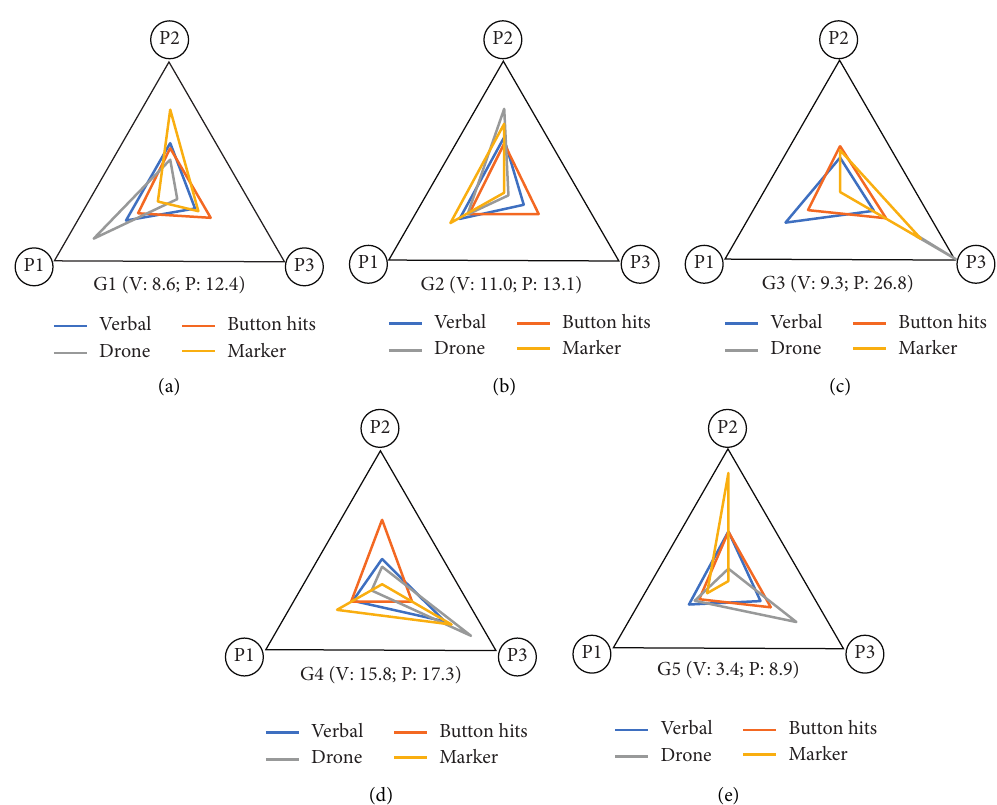
Figure 11: Overview of the results gained from the data on verbal participation, button hits, and drone and marker usage.